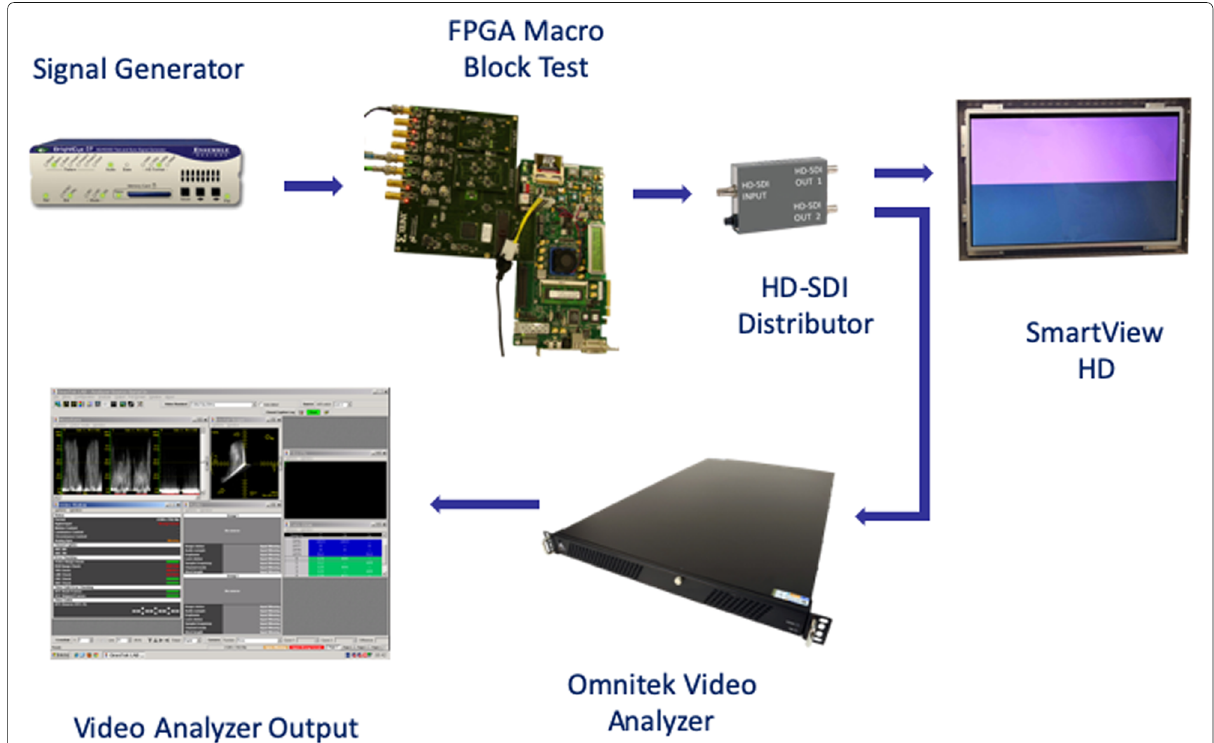
Fig. 12 System connection to test the macroblock FPGA input/output chain